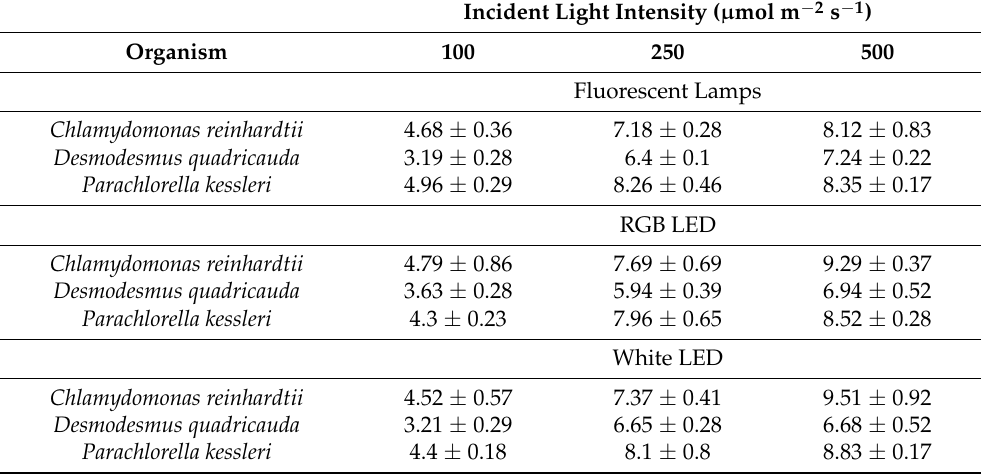
Table 1. Maximum optical density reached by cultures of Chlamydomonas reinhardtii , Desmodesmus quadricauda , and Parachlorella kessleri grown at different incident light intensities. Fold increase in opti- cal density between 0 and 23 h was calculated from the values of absorbance at 750 nm. Light source is stated above the columns. Data of three biological replicates are presented as means ± SE. Values were statistically significantly different between Desmodesmus quadricauda and both Chlamydomonas reinhardtii and Parachlorella kessleri but not between the latter two organisms; they were statistically sig- nificantly different between all light intensities in Chlamydomonas reinhardtii and Desmodesmus quadri- cauda but only between 100 and 250 µ mol m − 2 s − 1 (and 100 and 500 µ mol m − 2 s − 1 ) in Parachlorella kessleri (two-way ANOVA, Tukey’s HSD test, p < 0.05, n =